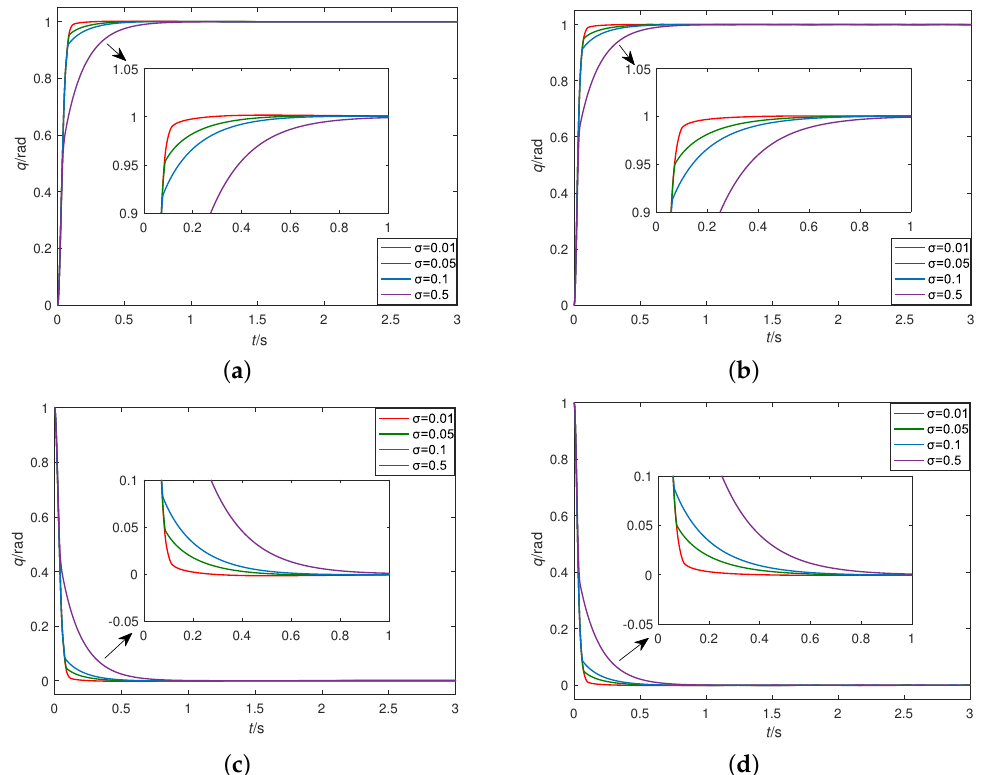
Figure 6. Position tracking curve and tracking error curve of two joints with different scale parameters. ( a ) Position tracking curve of Joint 1. ( b ) Position tracking curve of Joint 2. ( c ) Tracking error curve of Joint 1. ( d ) Tracking error curve of Joint 2.